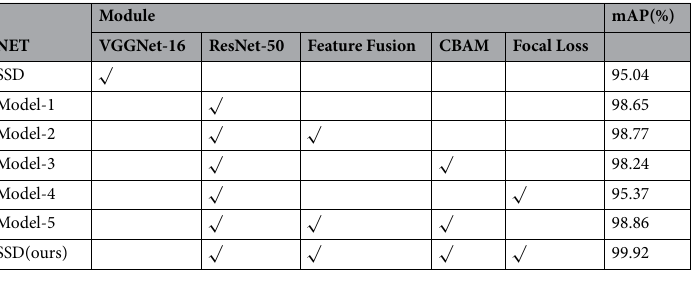
Table 2. Ablation experiment results on the passive terahertz